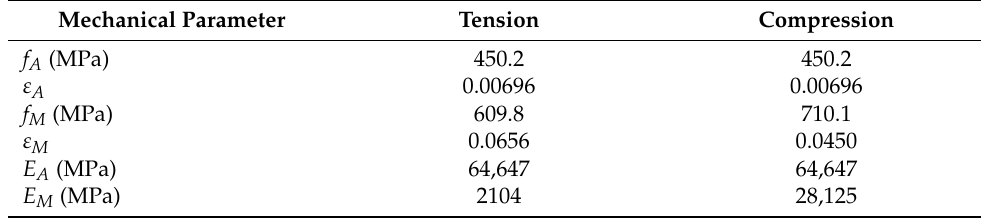
Table 5. NiTi reinforcement mechanical